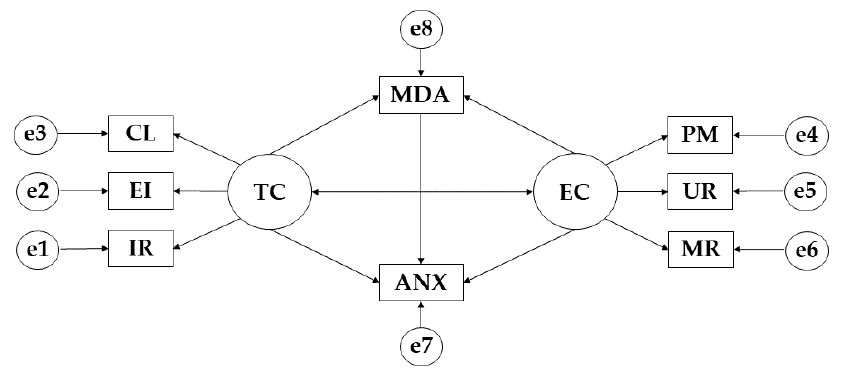
Figure 1. Proposed theoretical model. Note: EC = Ego climate; TC = Task climate; PM = Punishment for mistakes; UR = Unequal recognition; MR = Member rivalry; CL = Cooperative learning; EI = Effort/improvement; IR = Important role; ANX = Anxiety; MDA = Mediterranean diet adherence.